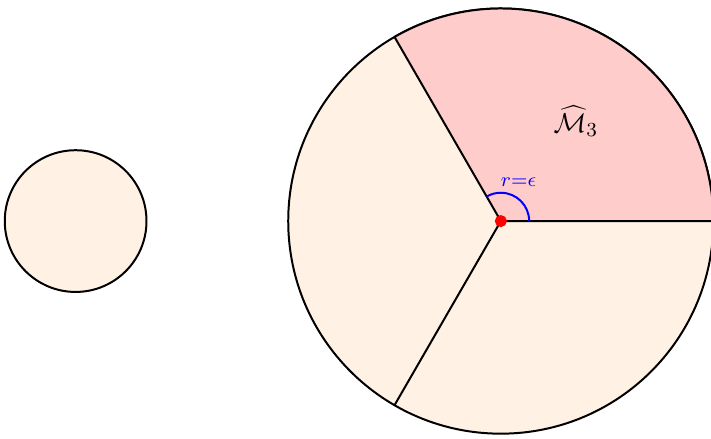
Figure 2 . The Poincaré disc geometry dual to the thermofield double (or Hartle-Hawking) state of JT gravity and its n -fold replica depicted here for n = 3 . We have shaded the single fundamental do- main obtained by taking the replica quotient and indicated the interior boundary at r = (cid:15) one intro- duces while computing the on-shell Euclidean action contribution from a single fundamental